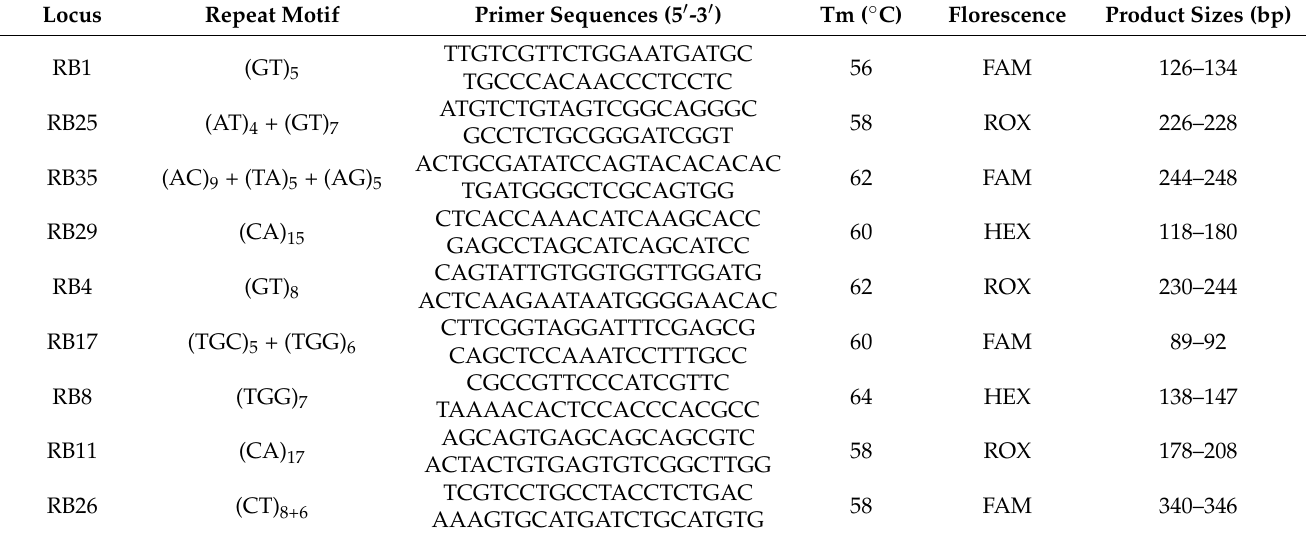
Table 1. Repeat motif, primer sequence, size, amplification conditions (Tm: annealing temperature), number and size in base pair (bp) of alleles of the 13 microsatellite